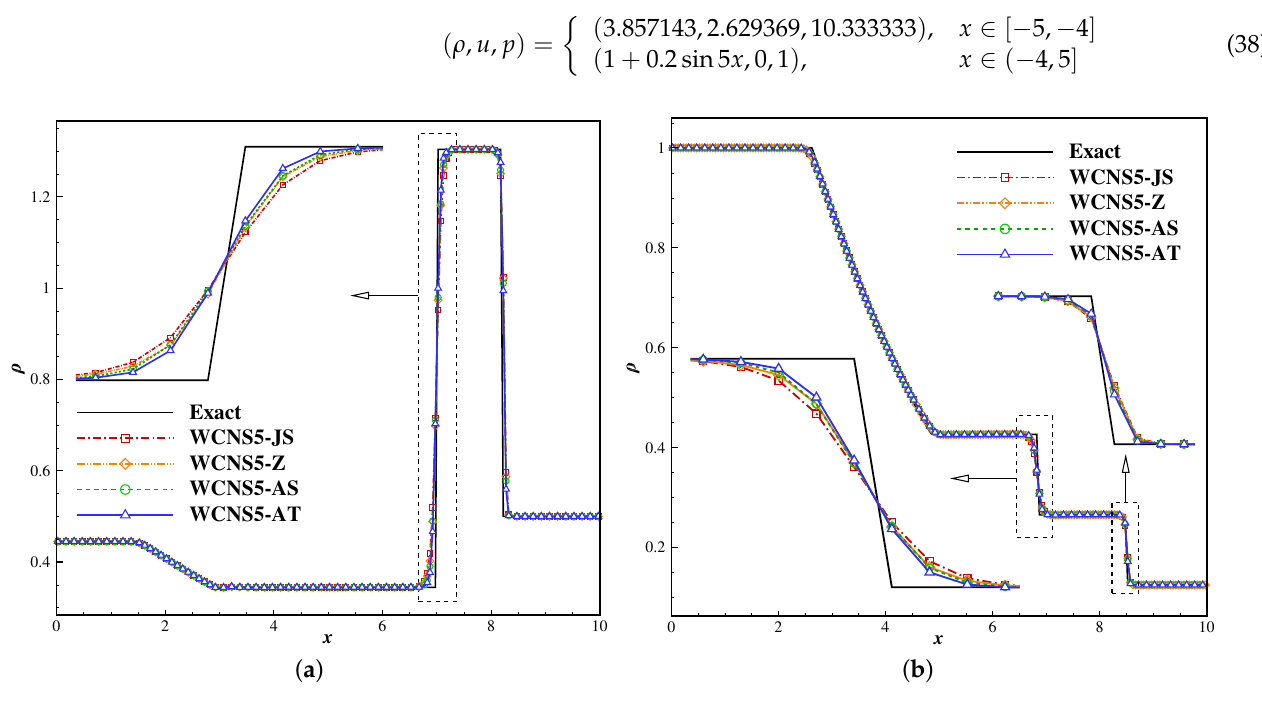
Figure 12. Density distribution of shock tube problem of Lax and Sod: ( a ) Lax; ( b ) Sod.